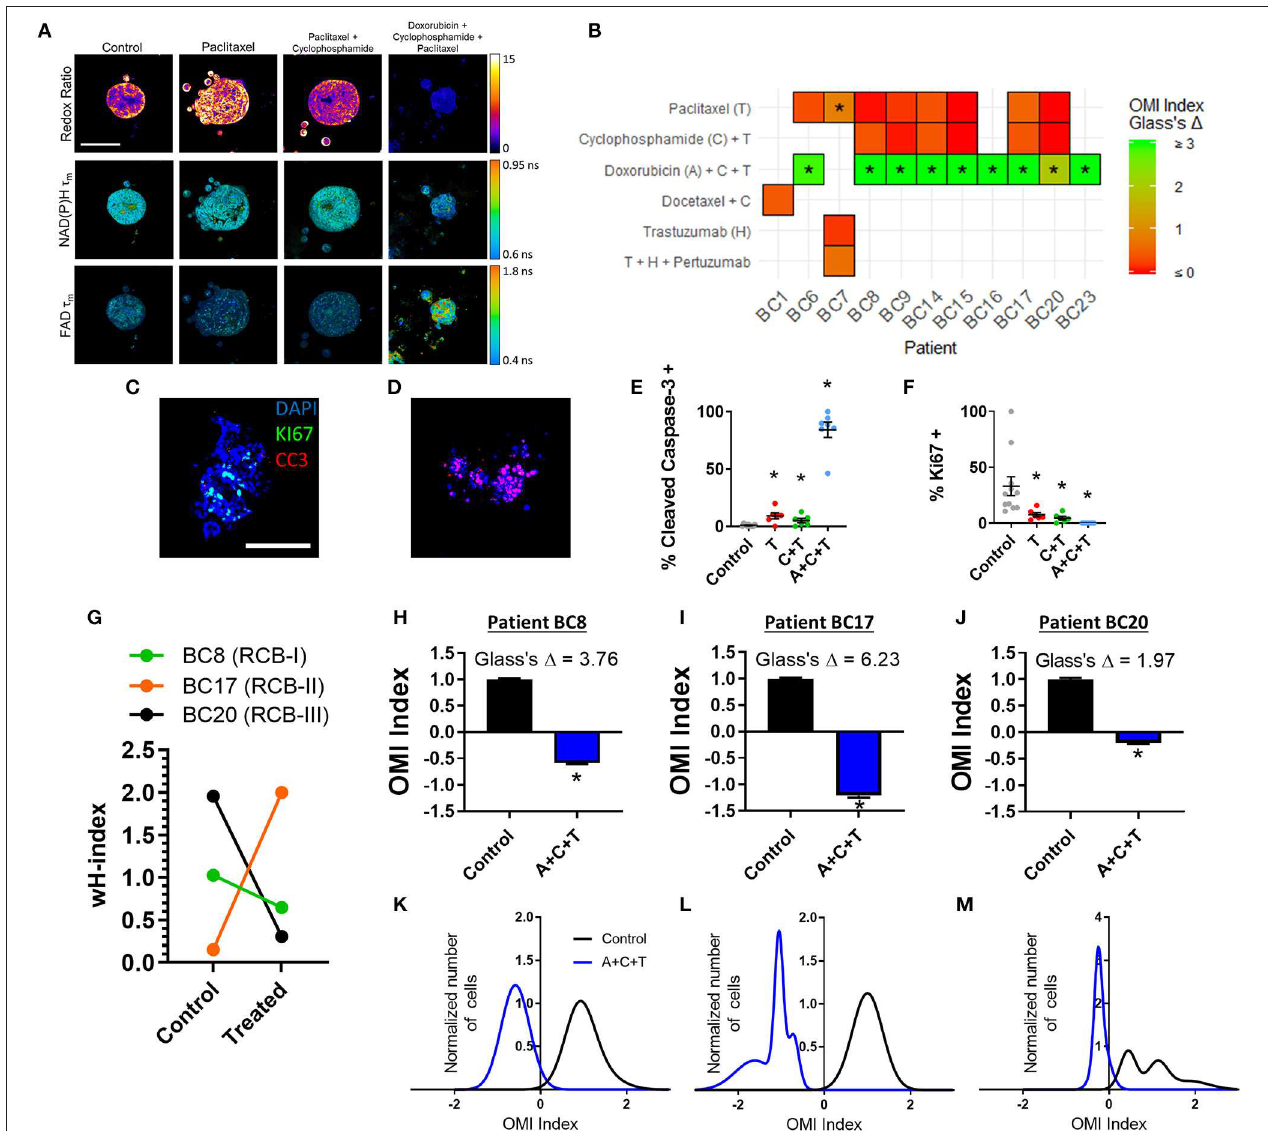
FIGURE 7 | OMI of single-cell treatment response in patient-derived breast tumor organoids. (A) Representative images of the optical redox ratio, NAD(P)H τ m , and FAD τ m organoids generated from Patient BC8 after 72h of treatment. Scale bar = 100 µ m. (B) Heatmap representation of the OMI index treatment effect size (Glass’s 1 ) at 72h in organoids from each breast cancer patient. *Glass’s 1 ≥ 0.75. 4-OOH cyclophosphamide (active metabolite) was used in place of cyclophosphamide. (C,D) Representative images of control (C) and A + C + T treated (D) BC8 organoids stained for Ki67 (green, proliferation), cleaved caspase-3 (red, apoptosis), and DAPI (blue, nuclei) after 72h of treatment. Scale bar 100 µ m. (E) Cleaved caspase-3 staining of organoids shows differences in apoptosis